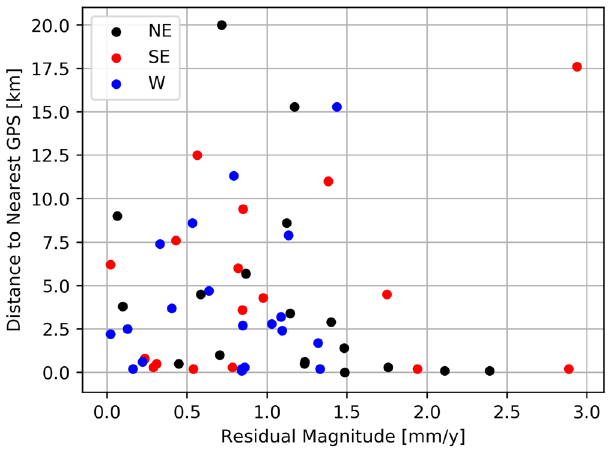
Fig. 9 Evaluation of residuals vs. distance to nearest GPS. Comparison of the magnitudes of the residuals at each tide-gauge location with the distance of the nearest